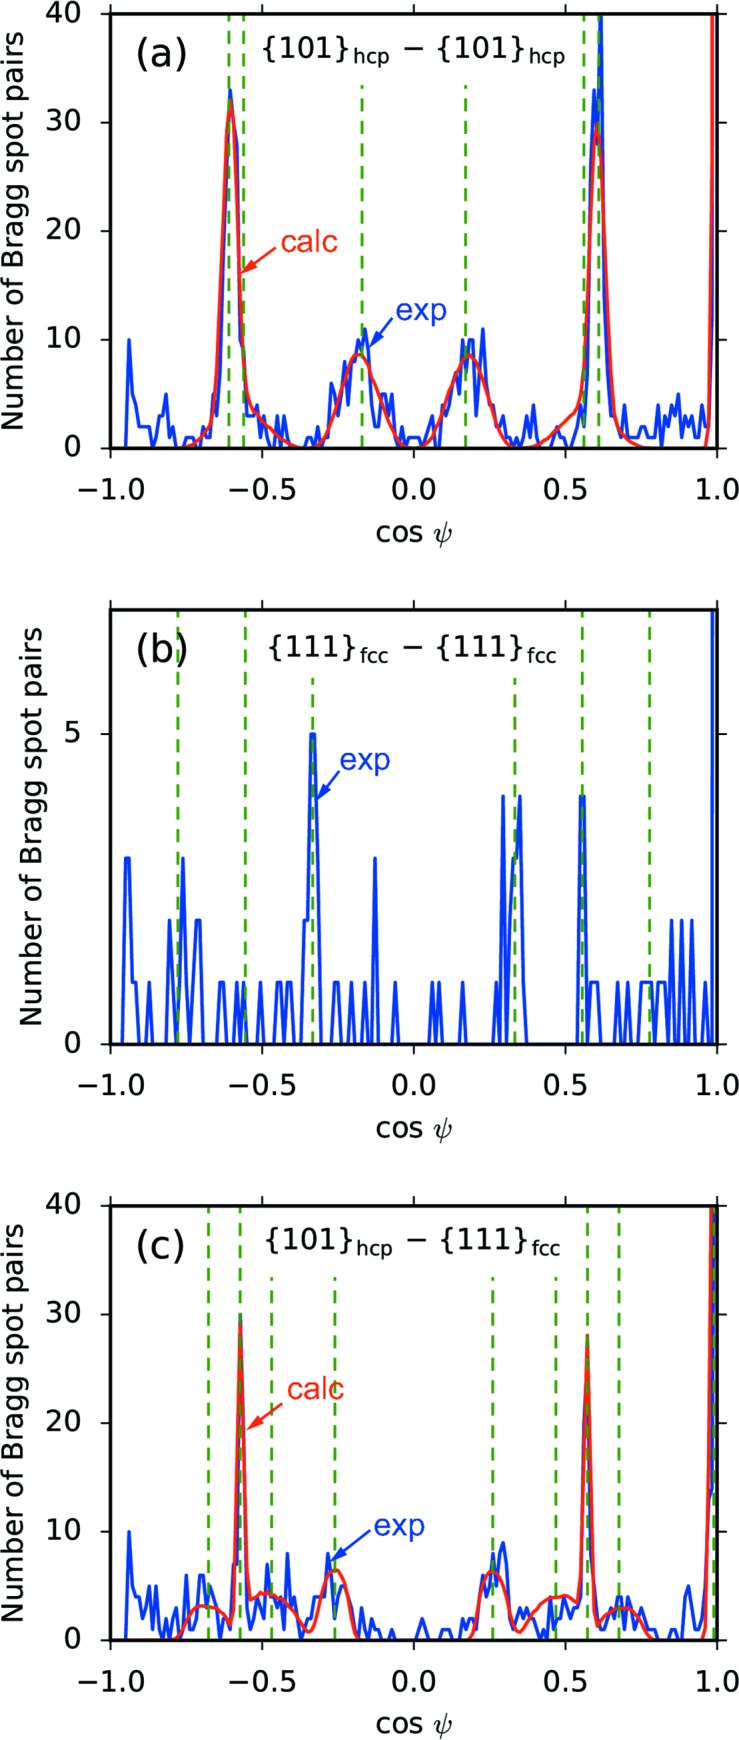
Results of angular-correlation analysis. The number of Bragg spot pairs are shown as functions of cos ψ. Blue lines depict the experimental angular correlations of (a) {101}hcp − {101}hcp, (b) {111}fcc − {111}fcc and (c) {101}hcp − {111}fcc. Green dashed lines depict the peak positions of the angular correlations calculated by evaluating cos ψ for the two corresponding reciprocal lattice vectors (see Appendix A
). Numerical simulations were performed to account for the peak broadening in (a) and (c) (red lines). The details of the simulation are provided in the main text. The optimized parameters in the simulation are σxy = 0.02 Å−1 and σz = 0.25 Å−1.